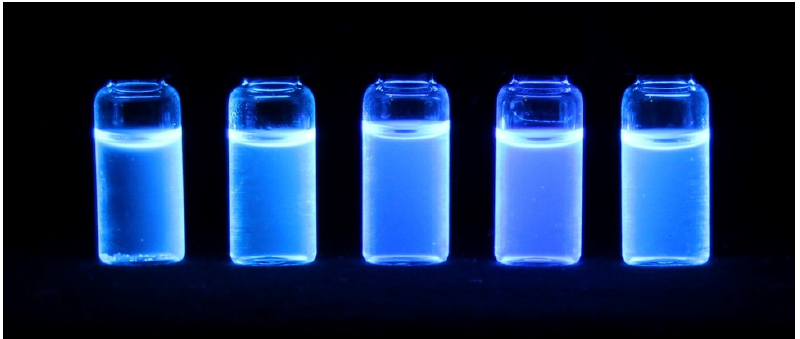
Figure 9. Fluorescence of N , N , N ’, N ’-tetraphenylnaphthidine ( 4 ) by excitation with UV light ( λ ex = 254 nm) in different solvents (concentration c = 2 mg mL − 1 and from left to right, isohexane, dichloromethane, ethyl acetate, THF, and methanol).